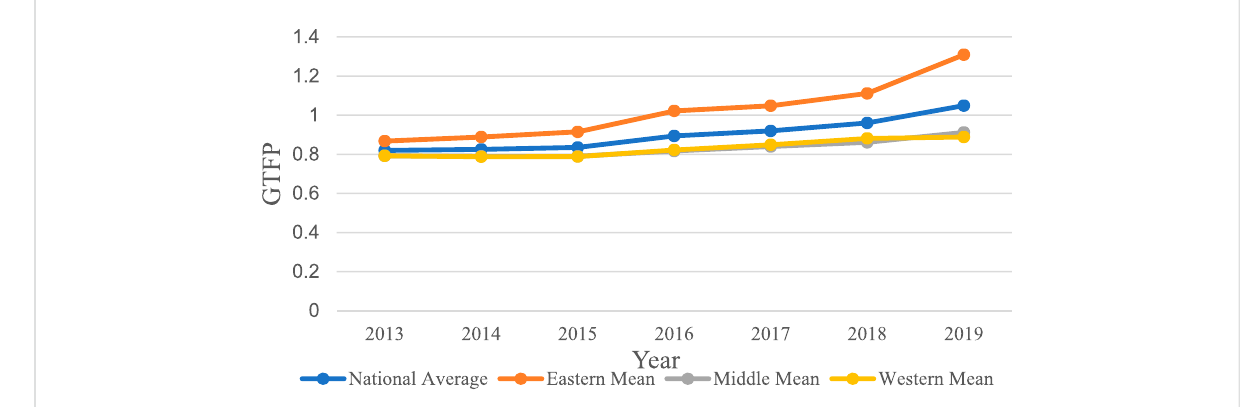
FIGURE 2 Regional green total factor productivity levels based on the super-ef fi cient SBM model.